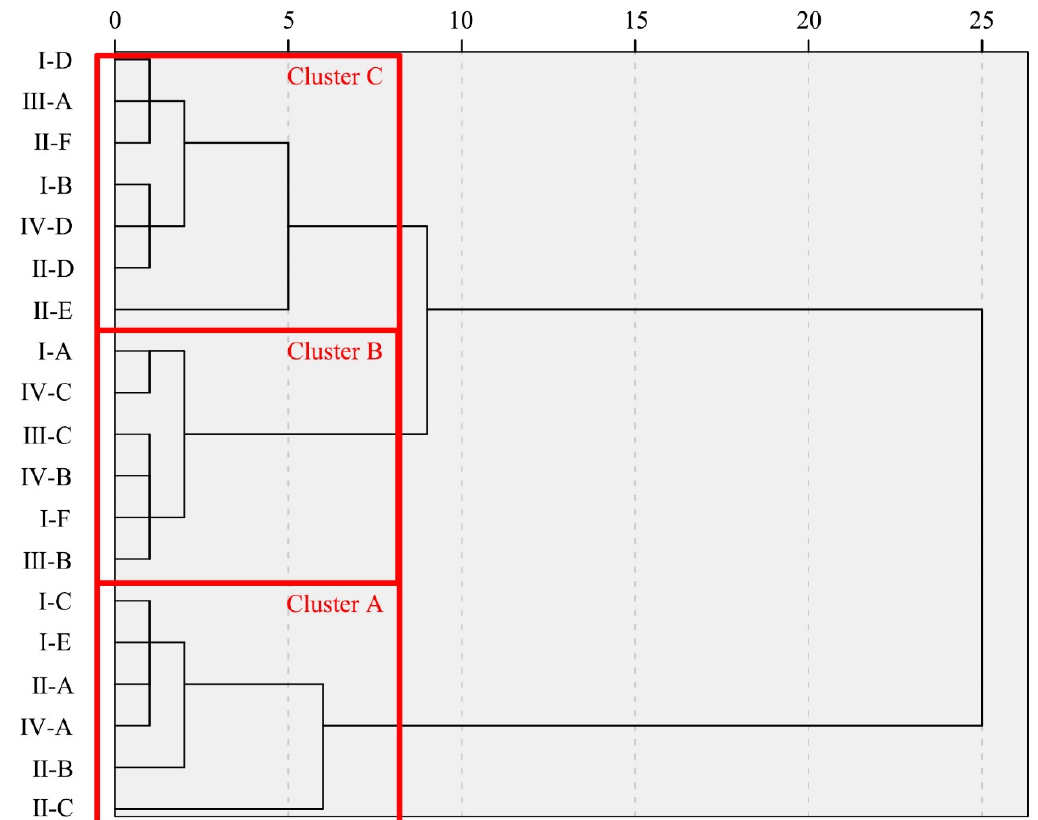
Figure 7. Hierarchical clustering analysis of the ratings of the ornamental features. Based on the Euclidean distance, these features were classified into three groups, Cluster A (high ratings), Cluster B (medium ratings), and Cluster C (low ratings). I-A–I-F represent grassland, shrub, broad-leaf tree, coniferous tree, bamboo, and palm, respectively; II-A–II-F represent blue, red, pink, purple, white, and yellow flowers, respectively; III-A–III-C represent green, yellow, and red leaves, respectively; IV-A–IV-D represent tree + shrub + grass, shrub + grass, shrub, and grass, respectively.